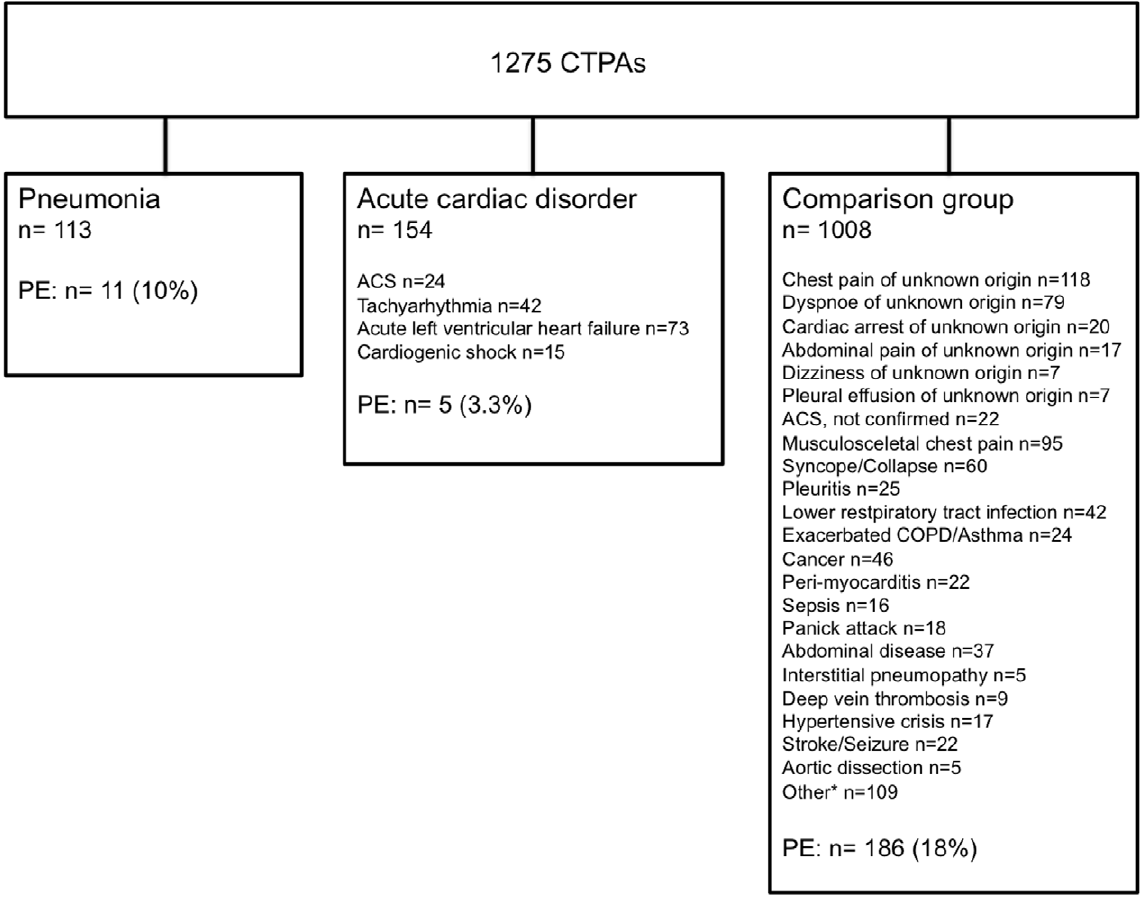
Figure 1. Frequencies of PE in patients with pneumonia, acute cardiac disorder, and in patients of the comparison group. CTPA denotes computed tomography pulmonary angiography. PE denotes acute pulmonary embolism. ACS, not confirmed denotes suspected acute coronary syndrome that was not confirmed by coronary angiography. Patients in the comparison group had either PE or one of the listed diagnoses at discharge from the emergency department. *Other: empyema, hematoma, leg pain or leg swelling of unknown origin, nephrotic syndrome, pneumothorax, obesity hypoventilation syndrome, sickle cell crisis, sinusitis, tuberculosis, malaise of unknown origin, fever of unknown origin, paralysis, elevated D-dimers of unknown origin, hemoptysis of unknown origin, cough of unknown origin, epiglottitis, hepatic encephalopathy, coma of unknown origin, anemia, ketoacidosis, anaphylactic reaction, struma, intoxication, spondylodiscitis, sternum infection, knee arthritis.